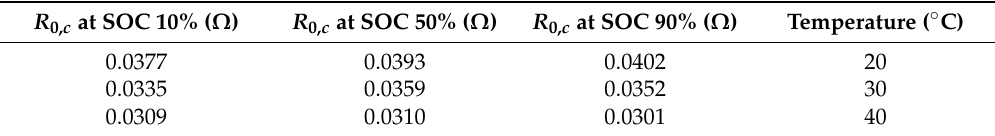
Table 2. Battery charge resistances measured for different SOC values and